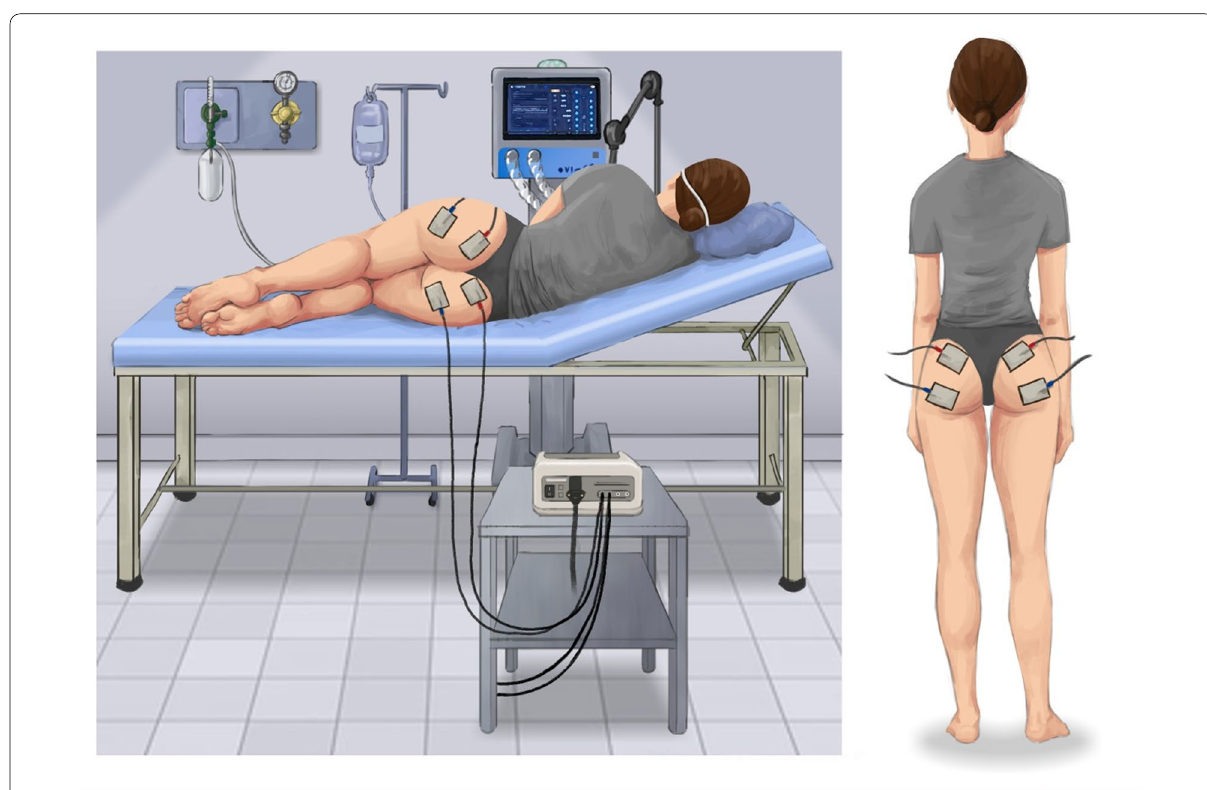
Fig. 1 Positioning of electrodes in the application of NMES. The figure shows the placement of the 9 bilaterally with a channel in each gluteus maximus muscle. The first electrode was attached just below the lateral iliac border and the second at the medial and superior insertion of the gluteus in the iliotibial tract, bilaterally, as described by Silva et al.